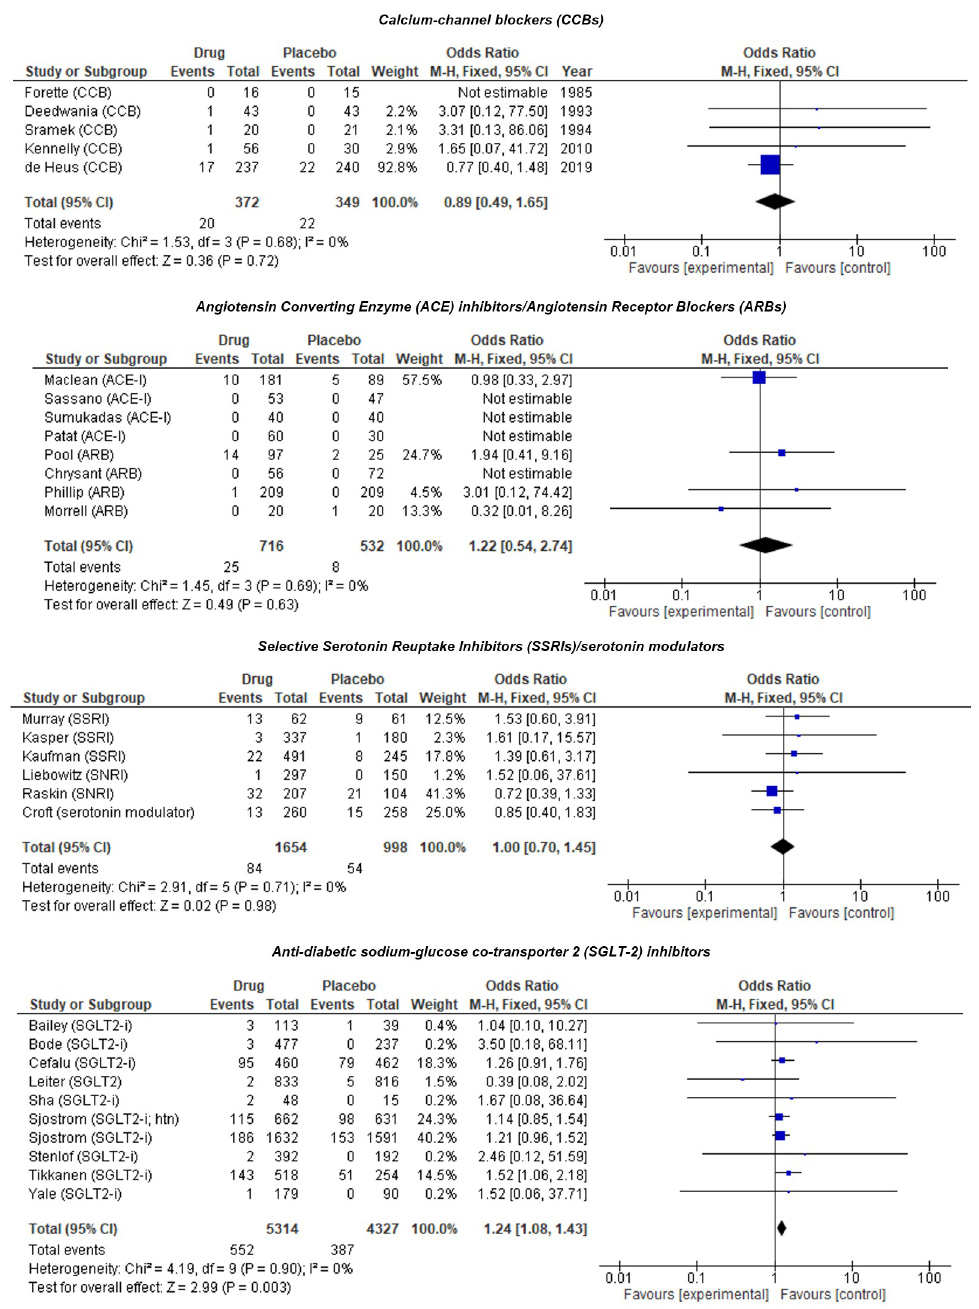
Fig 2. Meta-analysis results for vasodilators vs placebo. ACE, angiotensin-converting enzyme; ARB, angiotension receptor blocker; CCB, calcium channel blocker; SGLT-2, sodium–glucose cotransporter-2; SSRI, selective serotonin reuptake